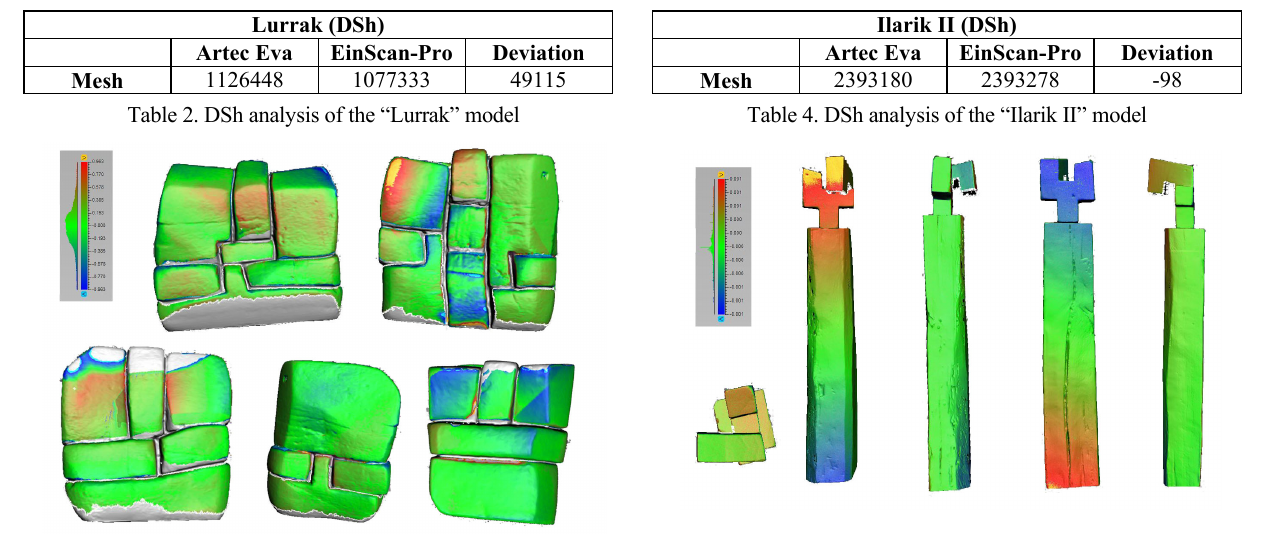
Figure 4. DF analysis of the “Lurrak” model